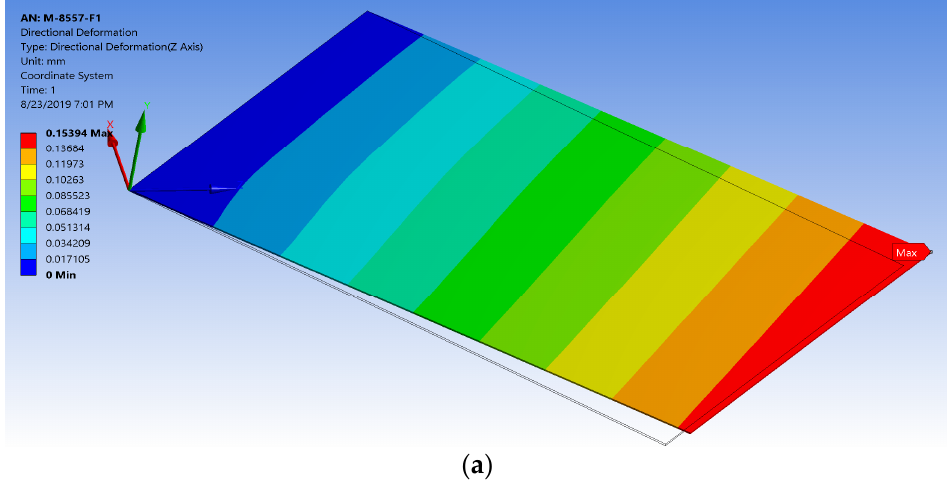
Figure 7. Simplified FE model of the electric field generated from the applied voltage difference of 255,000 V, which is equivalent to 1500 V in the physical MFC.